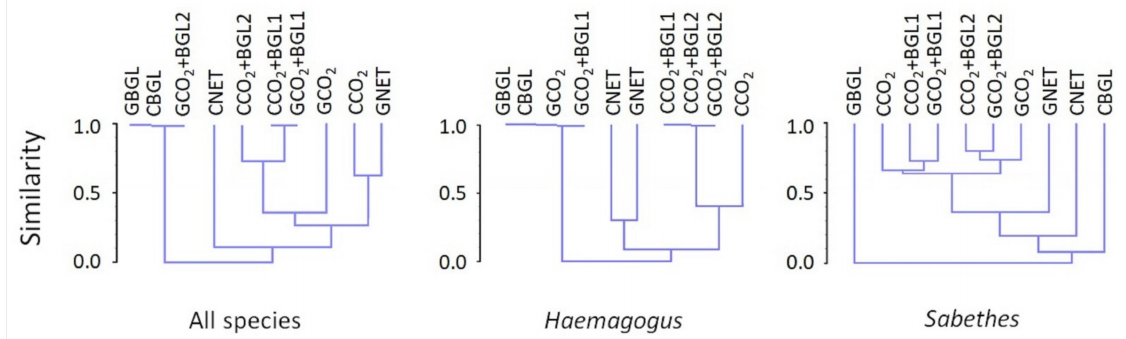
Figure 3. Hierarchical clustering with all female species and genus Haemagogus and Sabethes according to the method used and stratum. Note: CO 2 = CDC-like electrical trap using carbon dioxide; BGL = electric trap using the chemical attractant BG-Lure ® ; CO 2 + BGL (1,2) = two pairs of electrical traps using carbon dioxide and the commercial chemical attractant BG-Lure ® ; NET = hand-held insect